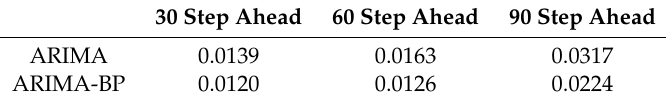
Table 2. RMSE of ARIMA and ARIMA-BP on CPU Usage.